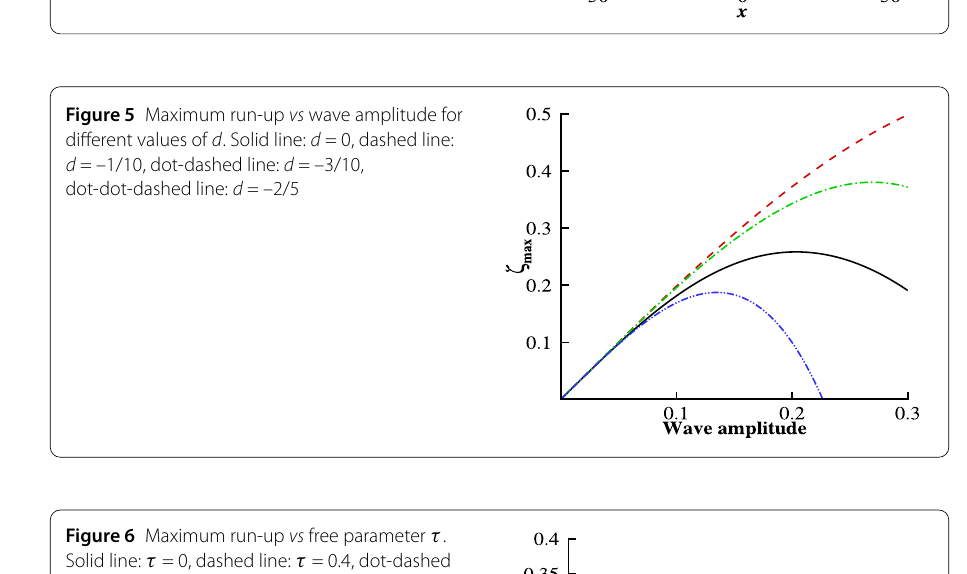
Figure 6 Maximum run-up vs free parameter τ . Solid line: τ = 0, dashed line: τ = 0.4, dot-dashed line: τ = 0.6, dot-dot-dashed line: τ =